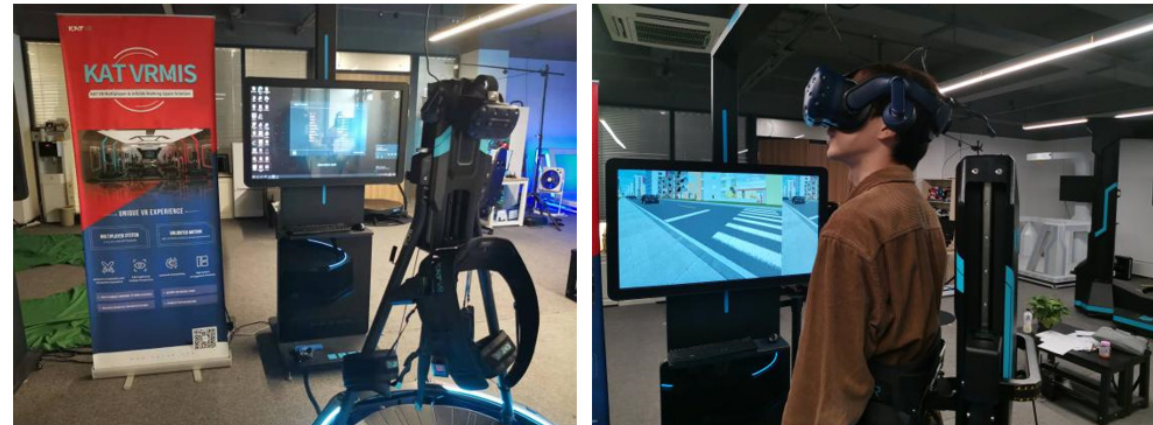
Figure 1. Walking simulation apparatus.